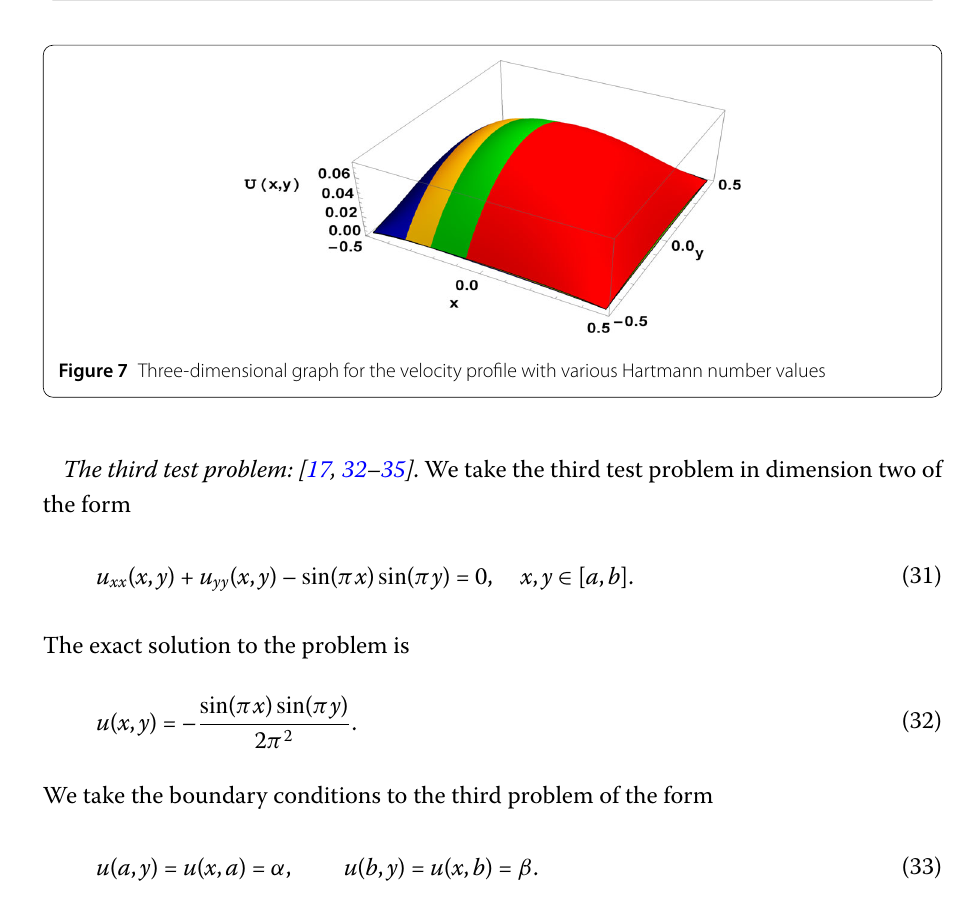
Figure 6 Various Hartmann number values are used to build a velocity profile